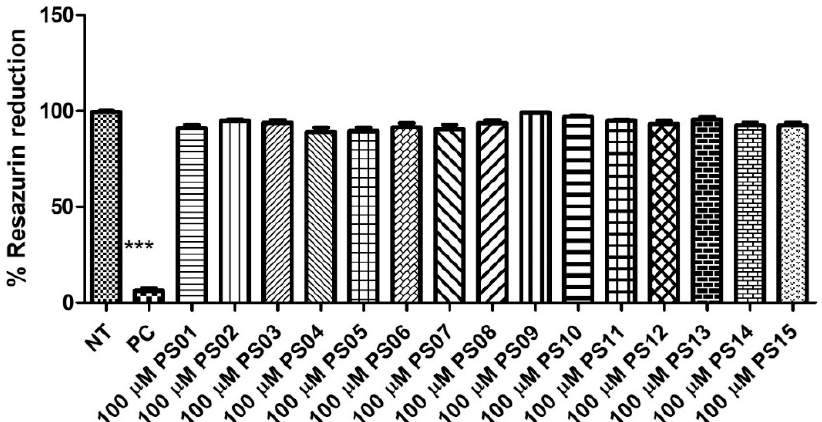
Figure 2. Quantification of cellular metabolic activity after treatment with the PS01–15 series employing the resazurin reduction capacity. Cells were treated with 10 μ M of the substances and 0.5% TX − 100 in the positive control (PC). Nontreated cells correspond to the negative control (NT). Comparison of NT vs. treatments. The error bar is representative of 3 experiments in triplicate on 3 different days. ANOVA (***) p <